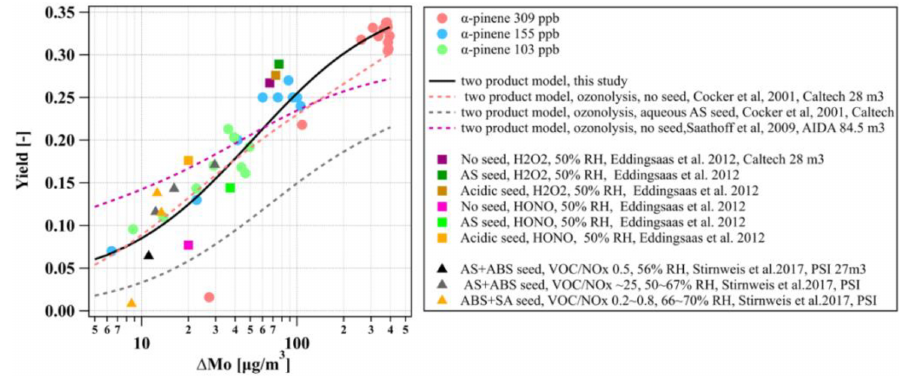
Figure 8. Yield curves derived from the photo-oxidation of α -pinene on aqueous AS seed conducted in this study and from literature data (Cocker et al., 2001a; Saathoff et al., 2009; Eddingsaas et al., 2012; Stirnweis et al., 2017). All experiments are carried out under humid conditions. Lines represent the two-product model fit for yield